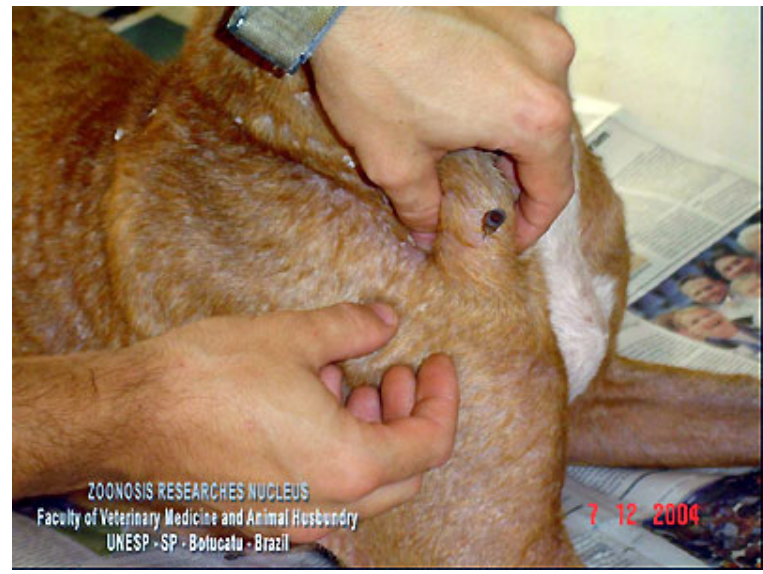
Figure 2: Puncture of the right pre-scapular lymph